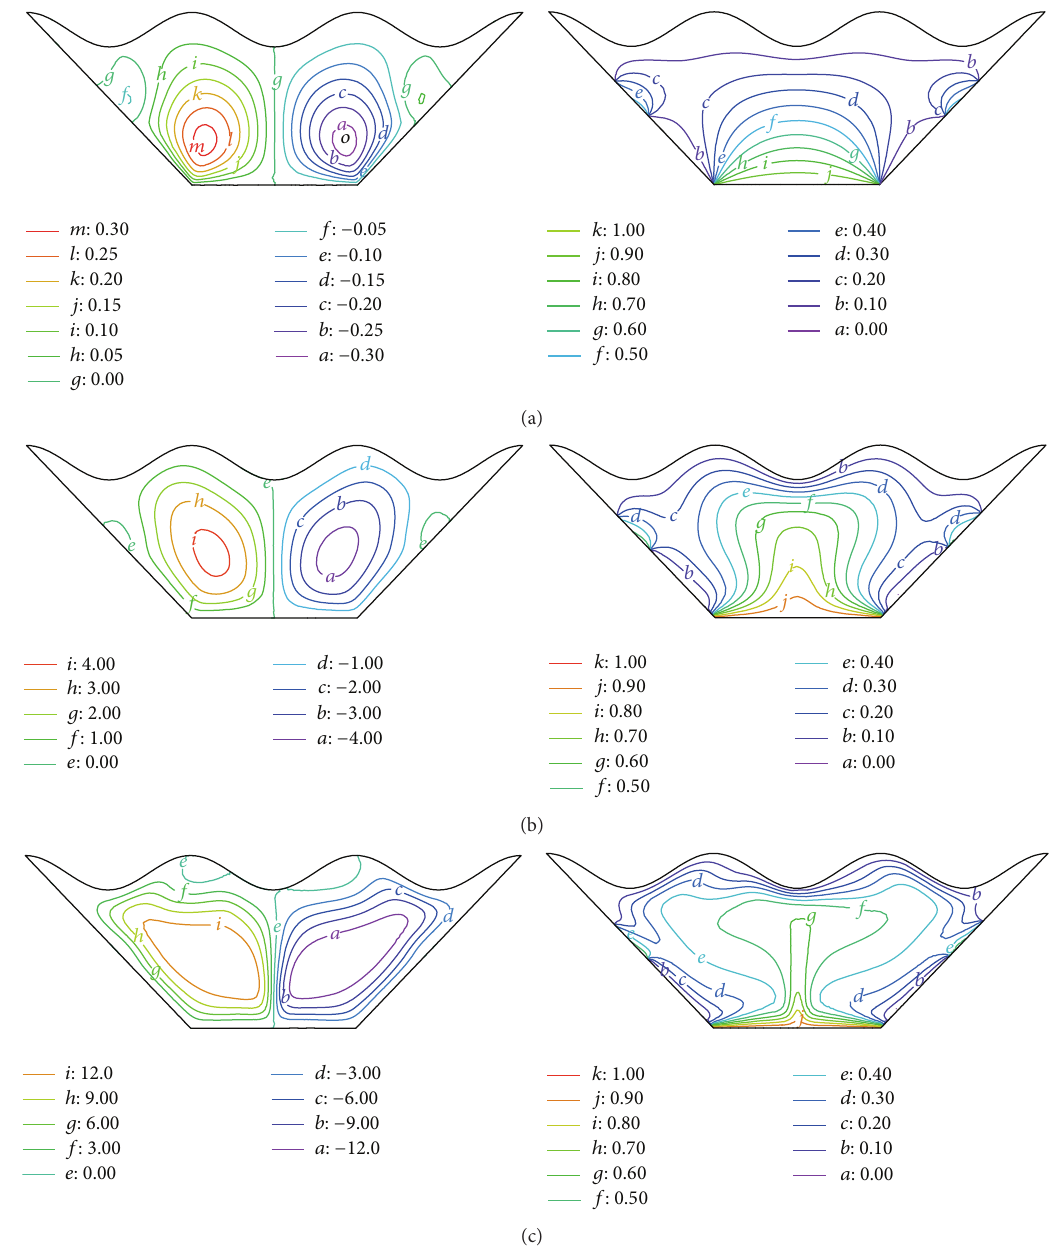
Figure 3: Streamlines (left) and isotherms (right) for 𝑎 = 0.9 and Ra = 10 6 . (a) Da = 10 −5 , (b) Da = 10 −4 , and (c) Da = 10 −3 .